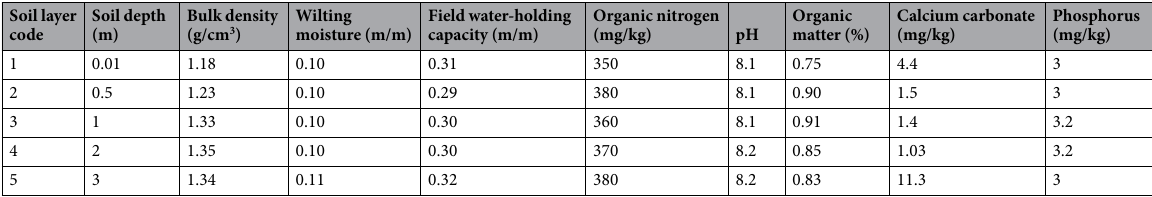
Table 3. Some important physical and chemical properties of Heilu clay soil in Luochuan.